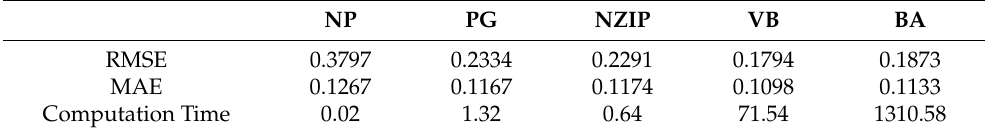
Table 4. Out-of-sample validation result with actual